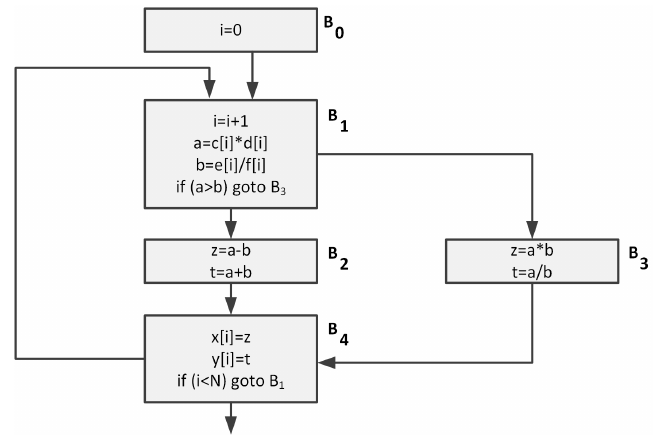
Figure 1. Control flow graph (CFG) example.